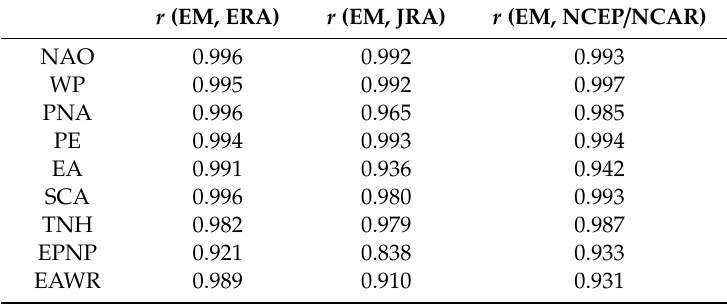
Table 2. Linear correlation coe ffi cients r between daily indices of nine teleconnection patterns based on ensemble mean and the three reanalysis datasets over the winter periods from 1979 to 2018. All coe ffi cients are significant at the α = 0.05 confidence